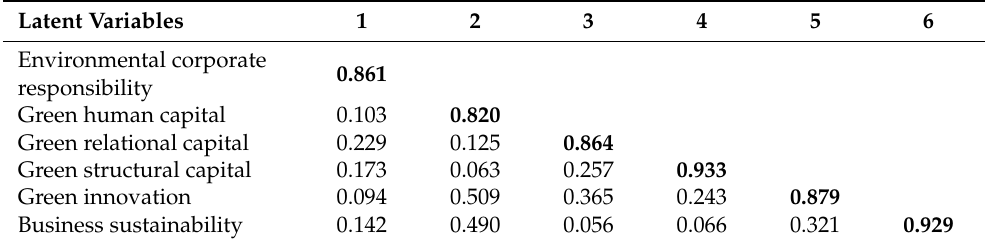
Table 5. Discriminant Validity (Fornell and Larcker